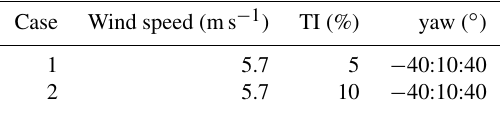
curves) are comparable. For the wind tunnel experiment, the loads are practically symmetric around the zero-degree yaw.